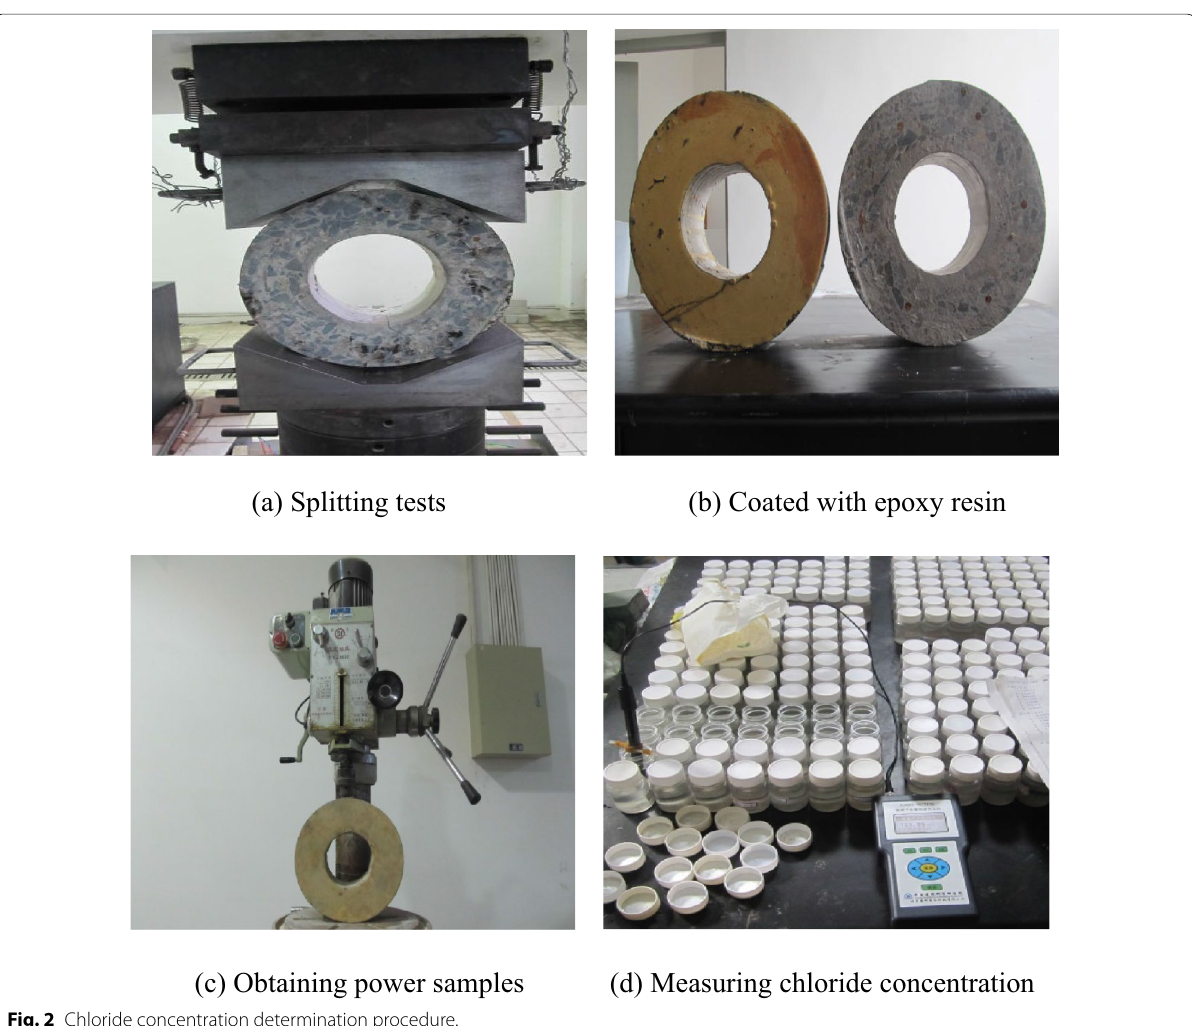
Fig. 2 Chloride concentration determination procedure.